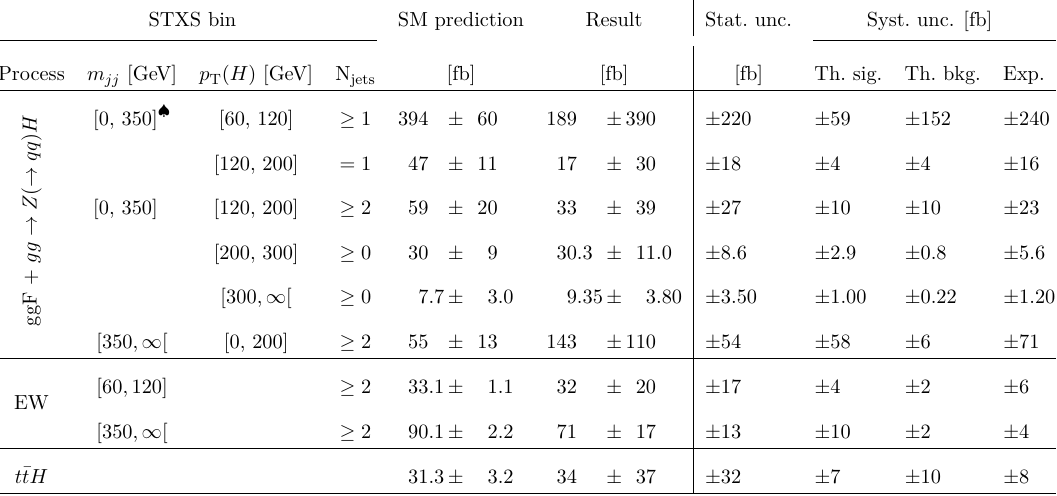
Table 15. Best-fit values and uncertainties for the pp → H → ττ cross-sections, in the reduced stage 1.2 STXS scheme described in the text. The EW production mode includes vector-boson fusion and qq → V ( → qq ) H processes. All measurements include the branching ratio of H → ττ and refers to true Higgs boson rapidity | y | < 2 . 5 . The SM predictions for each region, computed using the H inclusive cross-section calculations and the simulated event samples are also shown. The contributions to the total uncertainty in the measurements from statistical (Stat. unc.) or systematic uncertainties (Syst. unc.) in the signal prediction (Th. sig.), background prediction (Th. bkg.), and in experimental performance (Exp.) are given separately. Each uncertainty is reported as the average of its upward and downward fluctuations. The total systematic uncertainty, equal to the difference in quadrature between the total uncertainty and the statistical uncertainty, differs from the sum in quadrature of the Th. sig., Th. bkg., and Exp. systematic uncertainties due to correlations. The spades symbol ( ♠ ) indicates that the criteria for m only apply to events with at least two reconstructed jj